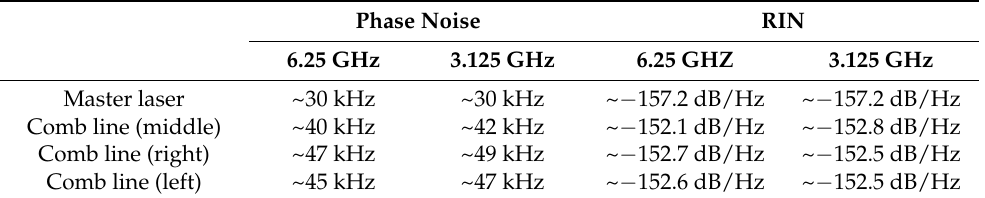
Figure 7. Relative intensity noise measurements for MIL-GS OFC of FSR ( a ) 6.25 GHz; (b) 3.125 GHz.